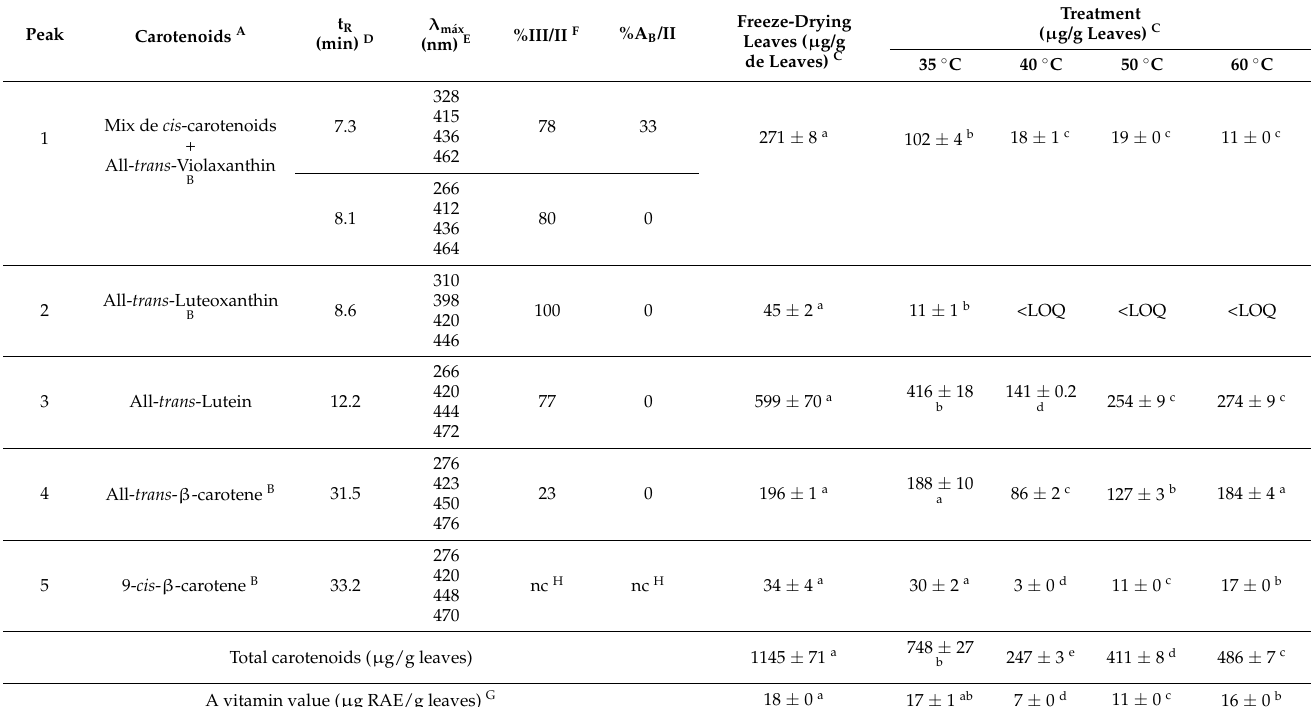
Table 4. Chromatographic characteristics, UV-Vis, and concentration of carotenoids obtained from leaves from Acmella oleracea by